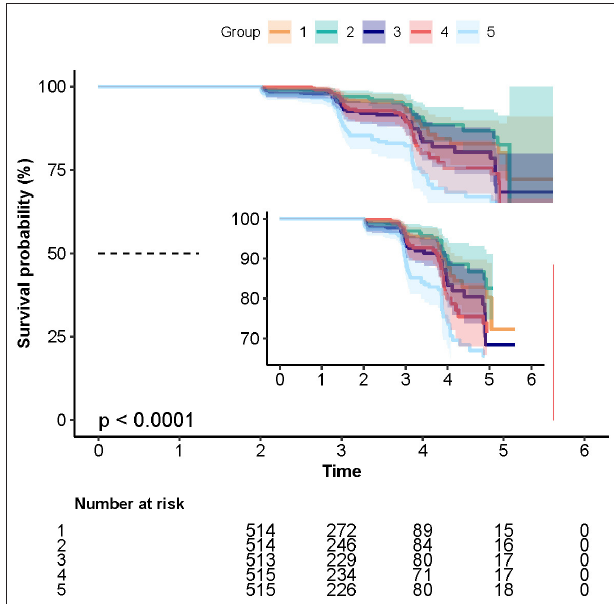
FIGURE 1 | The Kaplan–Meier curves depicting the cumulative incident type 2 diabetes mellitus (T2DM) in different quintile groups (Q1 to Q5) of triglyceride-glucose (TyG) index. Each color of lines indicates a quintile group. The color range indicates the 95% confidence internval (CI) range of cumulative incidence of T2DM at a different follow-up time.